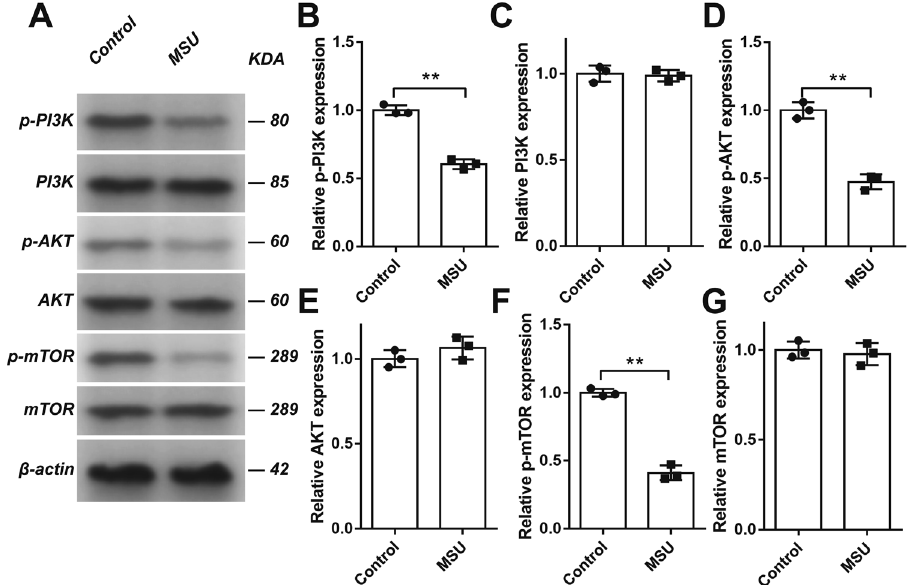
Fig. 4 MSU inhibited the PI3K/AKT/mTOR signaling pathway. C28/I2 cells were incubated with MSU (200 μ g/mL) for 24 h. The expression of p-PI3K ( A , B ), PI3K ( A , C ), p-AKT ( A , D ), AKT ( A , E ), p-mTOR ( A , F ), and mTOR ( A , G ) was detected by western blot assay. Results are the mean ± SD for three individual experiments. * P < 0.05, ** P < 0.01. safranin O-fast green, which stains basophilic cartilage tissues as red by safranin-O and eosinophilic bone tissues as green or blue by fast green. The safranin-O staining in cartilage displayed the production of proteoglycan and its changes re fl ected the damage of cartilage. Compared with control group, the MSU crystals decreased, while overexpression of Sox8 increased, the level of proteoglycans, indicating that Sox8 alleviated cartilage damage (Fig. 8A). Sox8 mediated MSU crystal-induced autophagy in vivo To verify the in vivo effect of Sox8 on PI3K/AKT/mTOR signaling pathway, the right ankle joints of rats were injected with vector or oe-Sox8 followed by the injection of 100 μ L of MSU crystals (30 mg/mL) one day later. Figure 8B – L shows the expression of